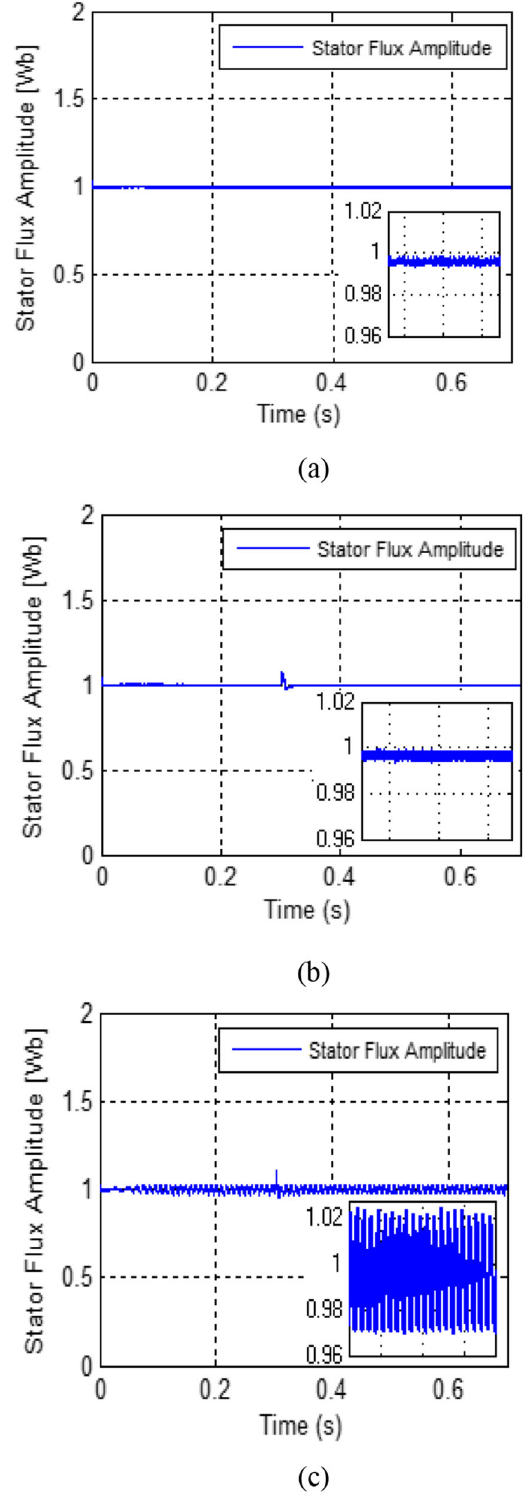
Fig. 11 Stator flux magnitude (Wb) ( a ) for SM-DTC with a three-level NPC inverter, ( b ) for SM-DTC with a two-level inverter and ( c ) for PI-DTC with a three-level NPC